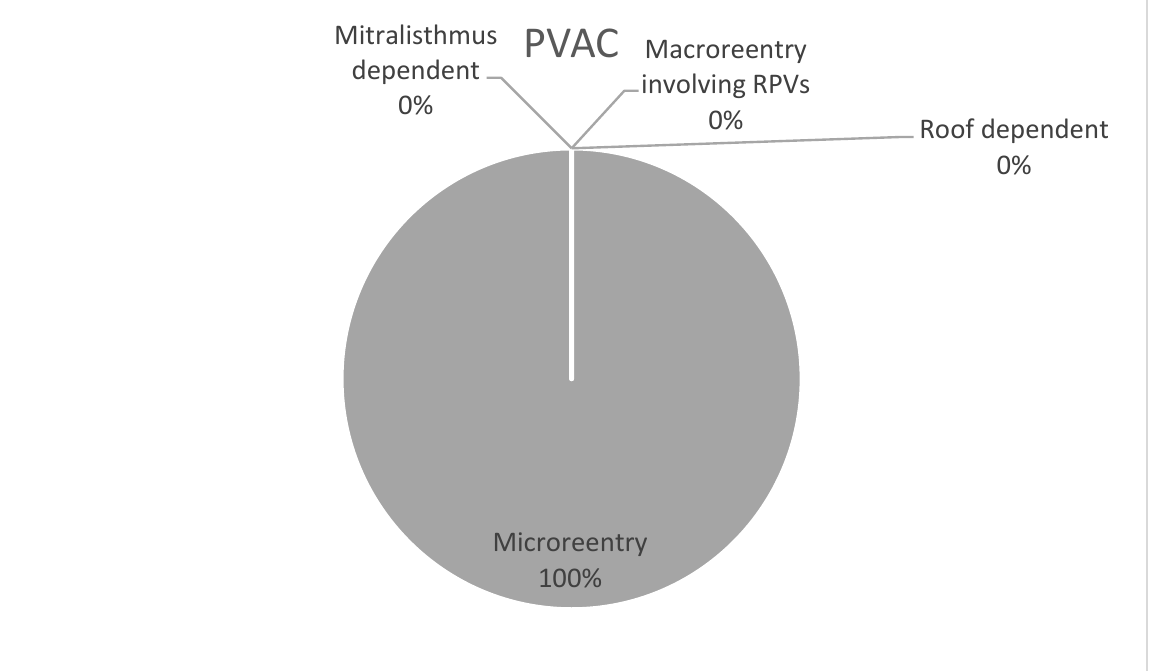
Figure 2. Schematic left anterior oblique view of the LA with the percentage of PV reconnections in the LAT patients.